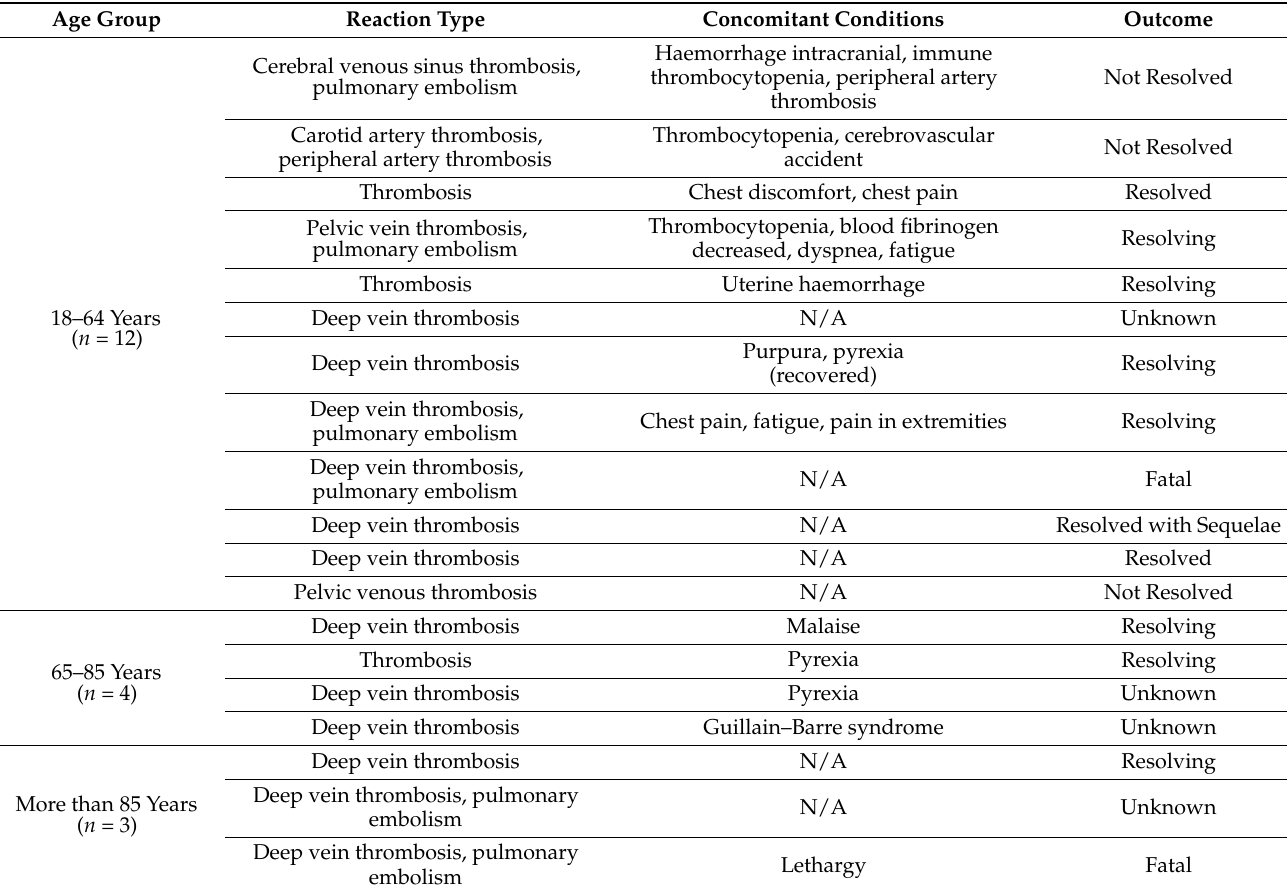
Table 3. Type of thromboembolic reaction and clinical outcome for female cases by age group ( N = 19/28). Age Group